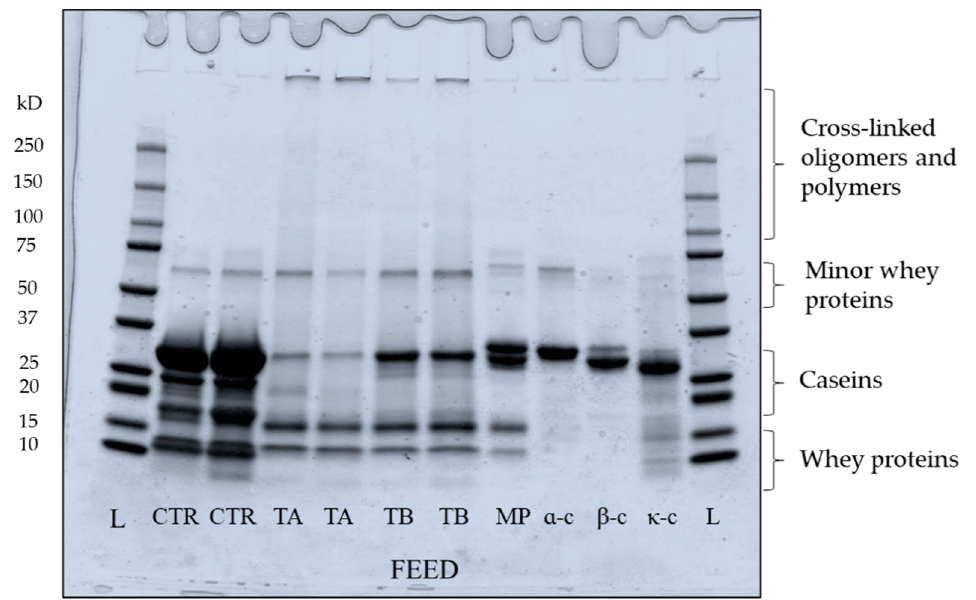
Figure 1. Electrophoretic patterns under reducing conditions of mTG crosslinked micellar casein concentrate feeds used in microfiltration at 5 ± 0.5 °C. Bands represent samples from two independent runs at each treatment. L: ladder; CTR: Control; TA: 5 °C/24 h; TB: 40 °C/90 min; MP: low heat skim milk powder; α -c: α s -casein; β -c: β -casein; κ -c: κ -casein.